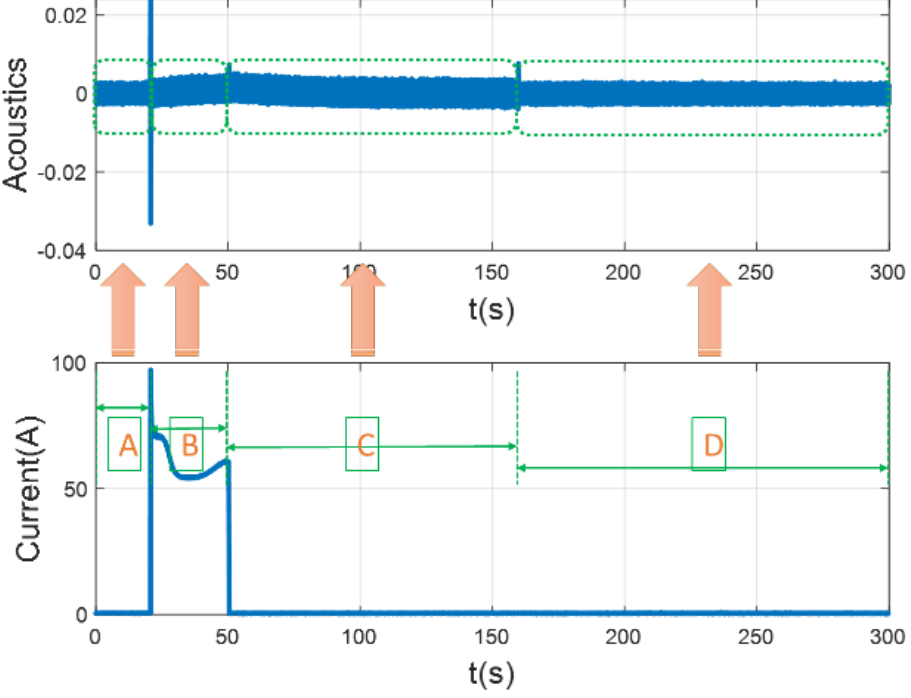
Figure 3. Segmentation diagram of an acoustic signal.